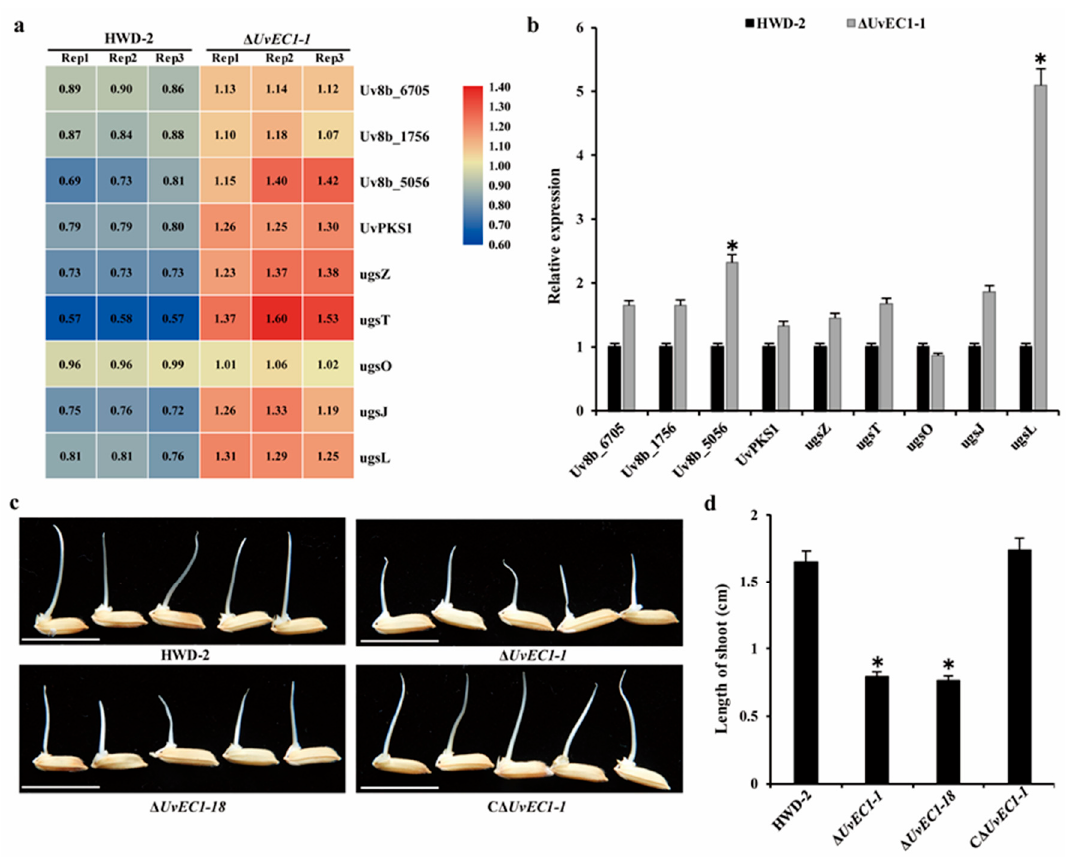
Figure 9. Deletion of UvEC1 affects the protein accumulation and expression of toxin-encoding genes. ( a ) Heatmap analysis of levels of toxin-biosynthesis-related proteins in the ∆ UvEC1-1 mutant and HWD-2. ( b ) RT-qPCR analysis of toxin-biosynthesis-related genes in HWD-2 and ∆ UvEC1 . β -tubulin was used as reference gene. ( c ) Reduced inhibition of rice seed germination by culture filtrates of the ∆ UvEC1 mutants. Shoot lengths were measured after 5 d at 28 ◦ C under illumination in growth incubators. ( d ) Mean length of rice shoots treated with filtrates from the indicated cultures. 50 rice seeds were shifted to 25-mL culture filtrates at 28 ◦ C for 5 d. Three independent experiments ( n =100) were carried out (mean ± SD), bar =10 mm. Asterisks represent significant differences relative to HWD-2, as determined by LSD at p =